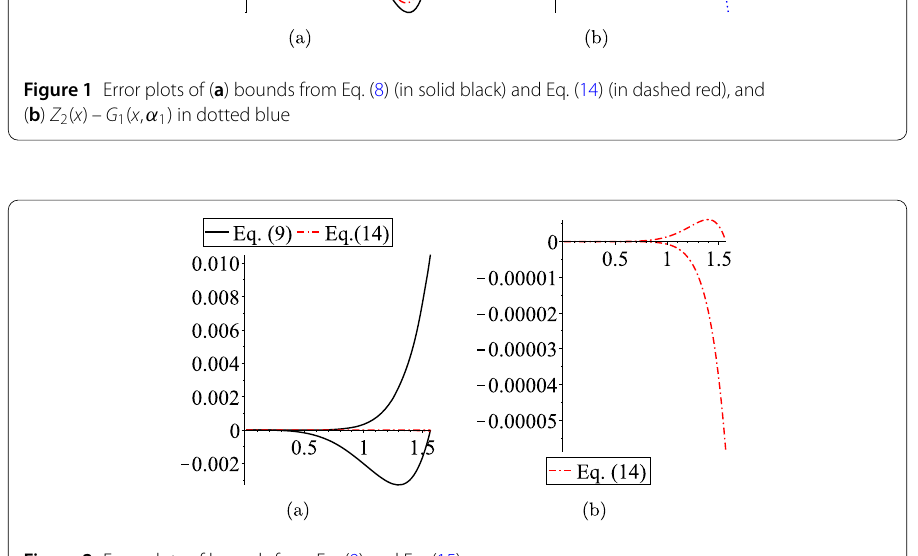
Figure 2 Error plots of bounds from Eq. (9) and Eq.